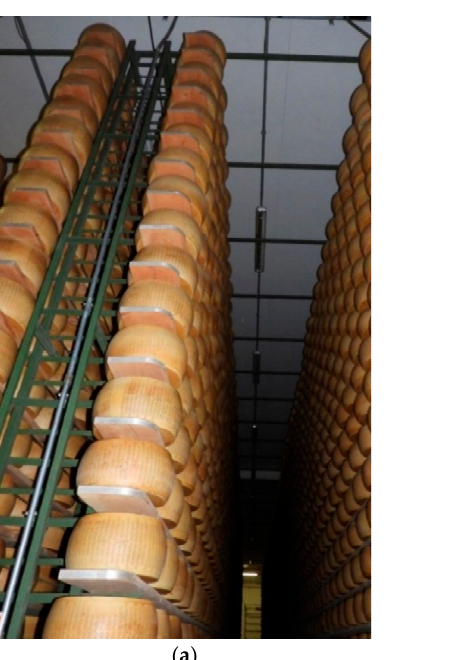
( b ) Figure 2. Details of the old type grana cheese racks: ( a ) picture and ( b ) sketch.